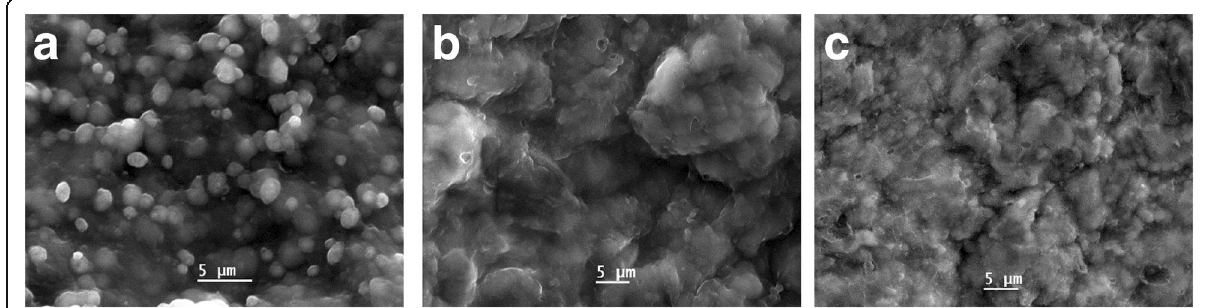
Fig. 3 SEM micrographs of the prepared CSM/SA hybrid beads: a before metal adsorption, b After Cr(VI) loading, c After Pb(II) loading